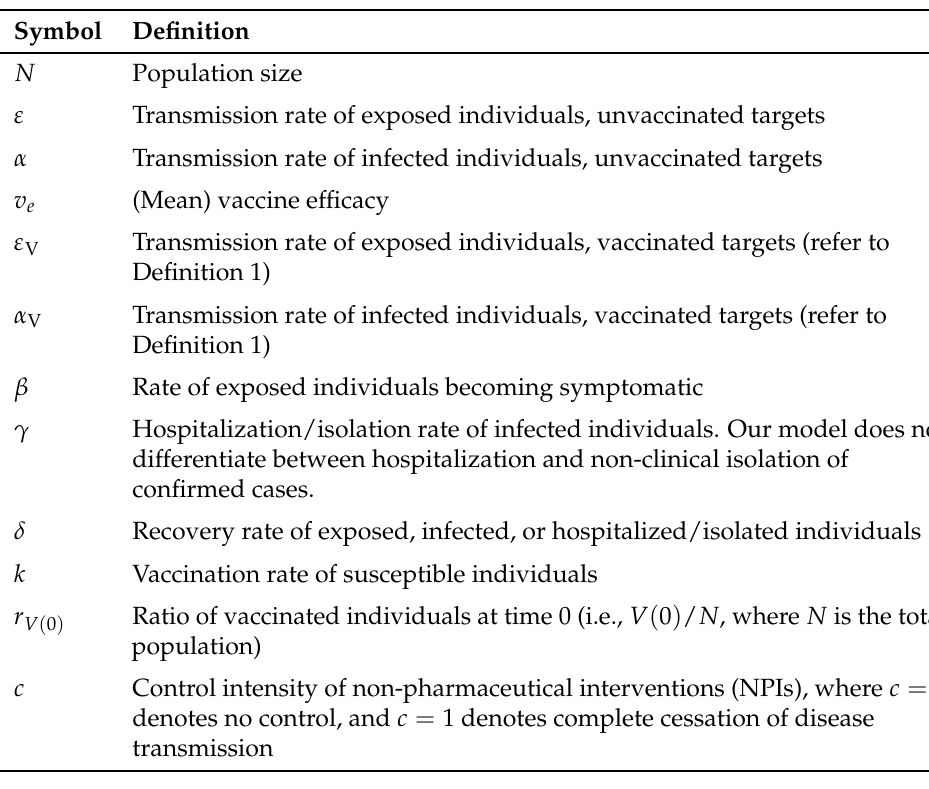
Table 1. List of symbols and parameters for the SVEIHR model depicted in Figure